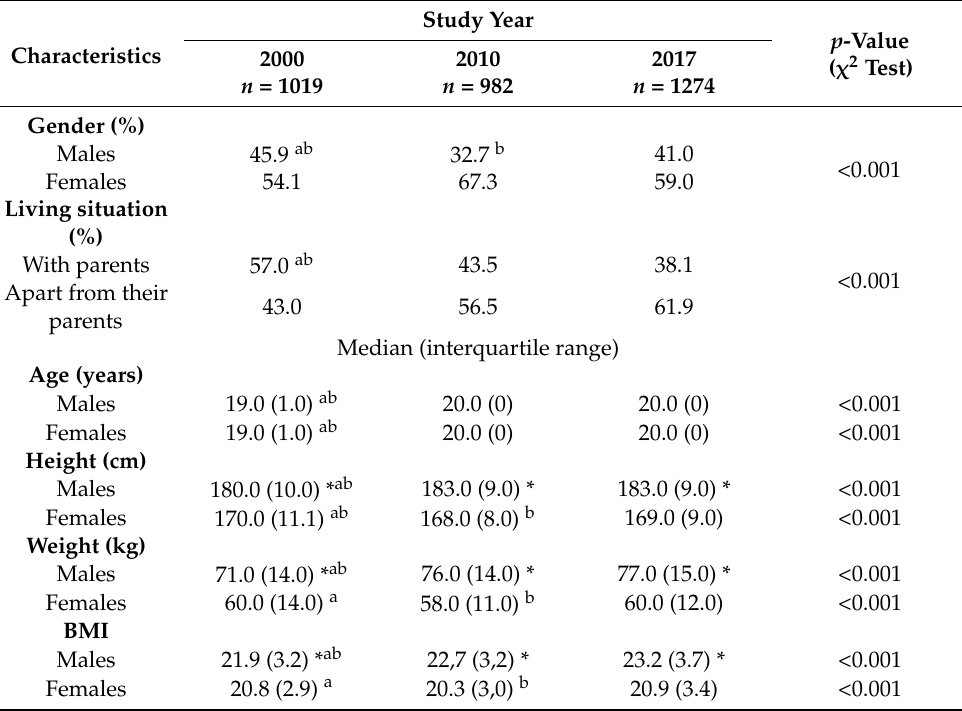
Table 1. Characteristics of the study population in 2000, 2010 and 2017.